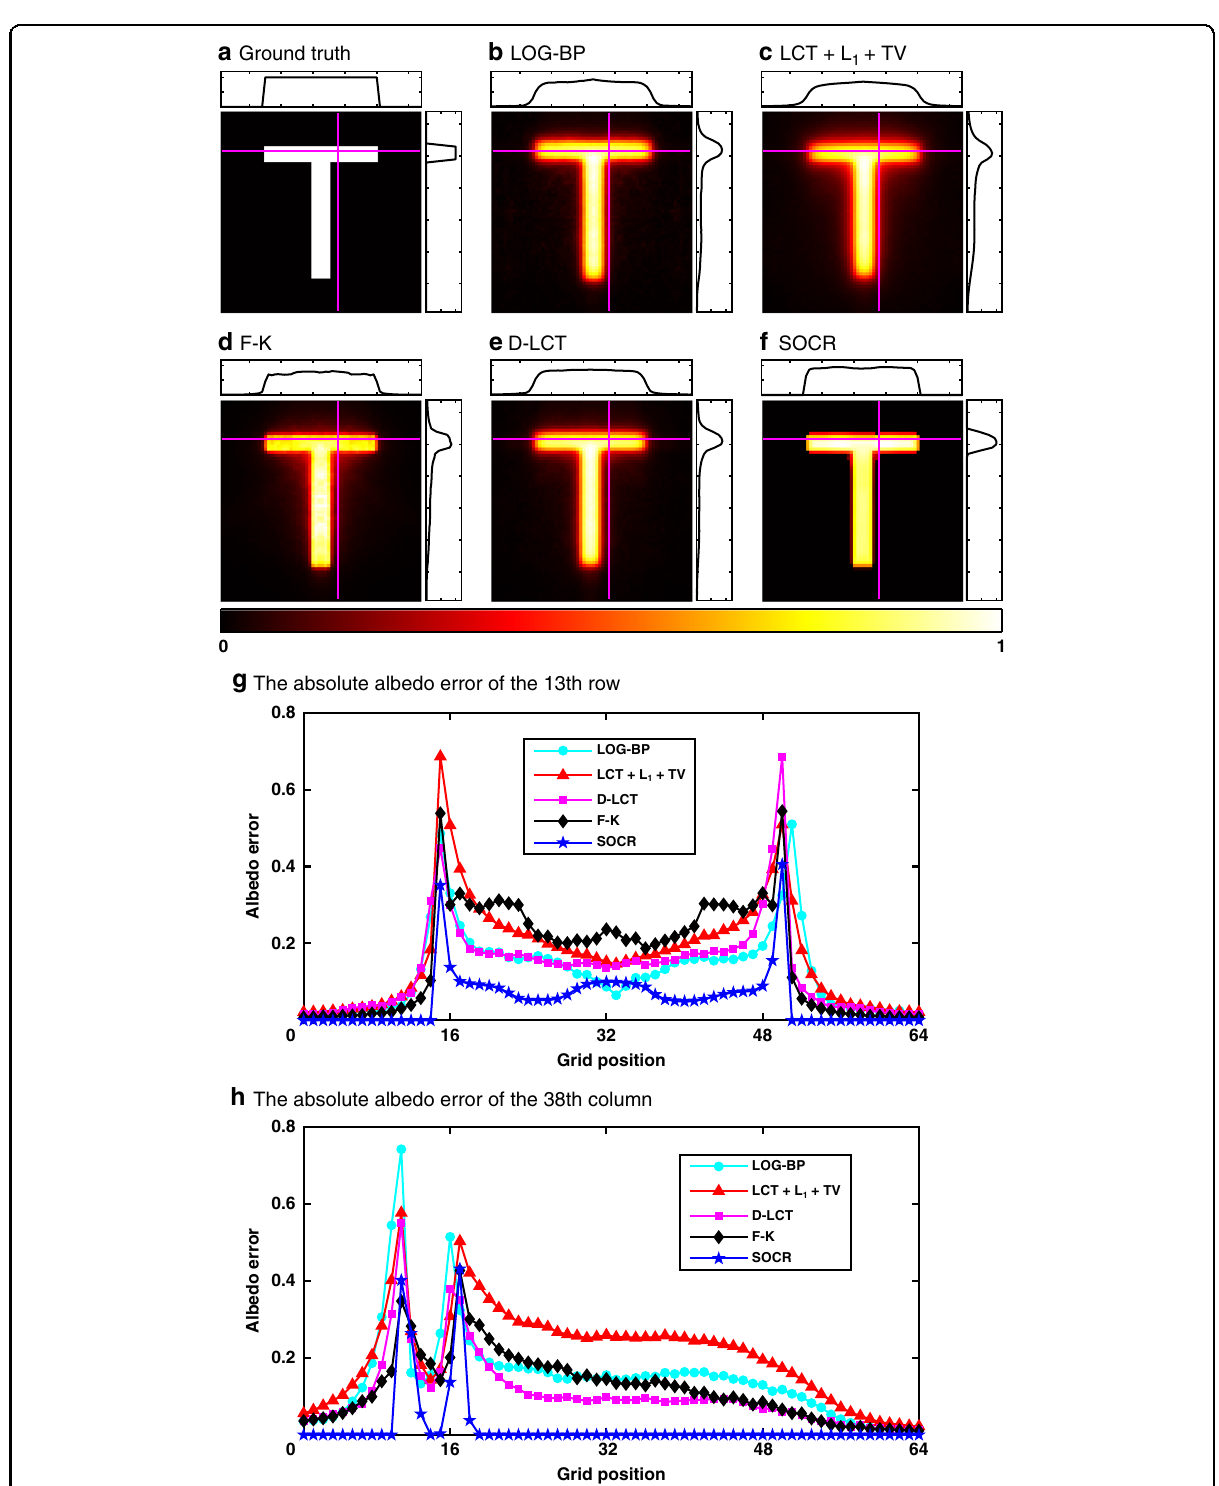
Fig. 2 Reconstruction results of the letter T (confocal). The ground truth is shown in a . Reconstructed albedo is shown in b – f . The absolute albedo error of two cross-section lines (the 13th row and 38th column) are shown in g and h . The proposed method has the smallest